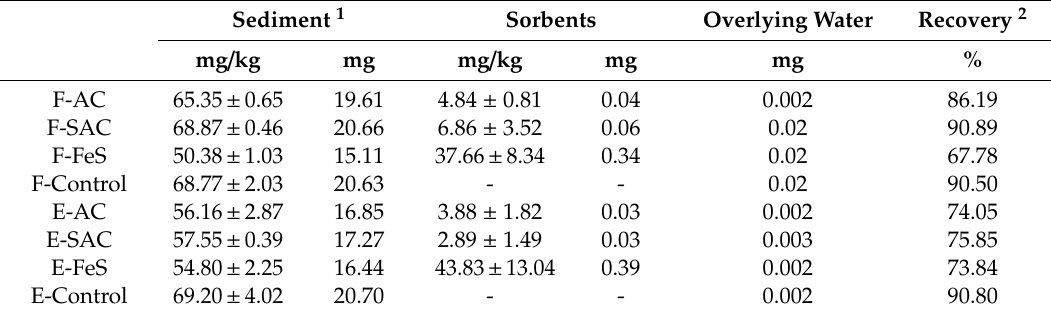
Table 3. Recovery calculation based on the Hg content in sediment, sorbents and overlying water after 65 days in the microcosms. 65 days in the microcosms.